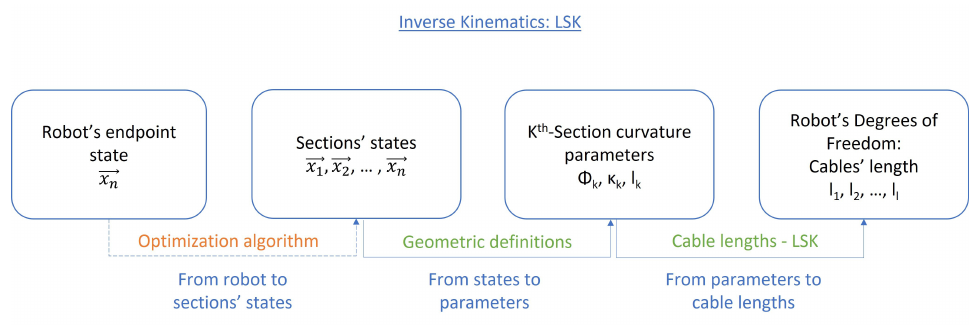
Figure 14. Inverse kinematics for